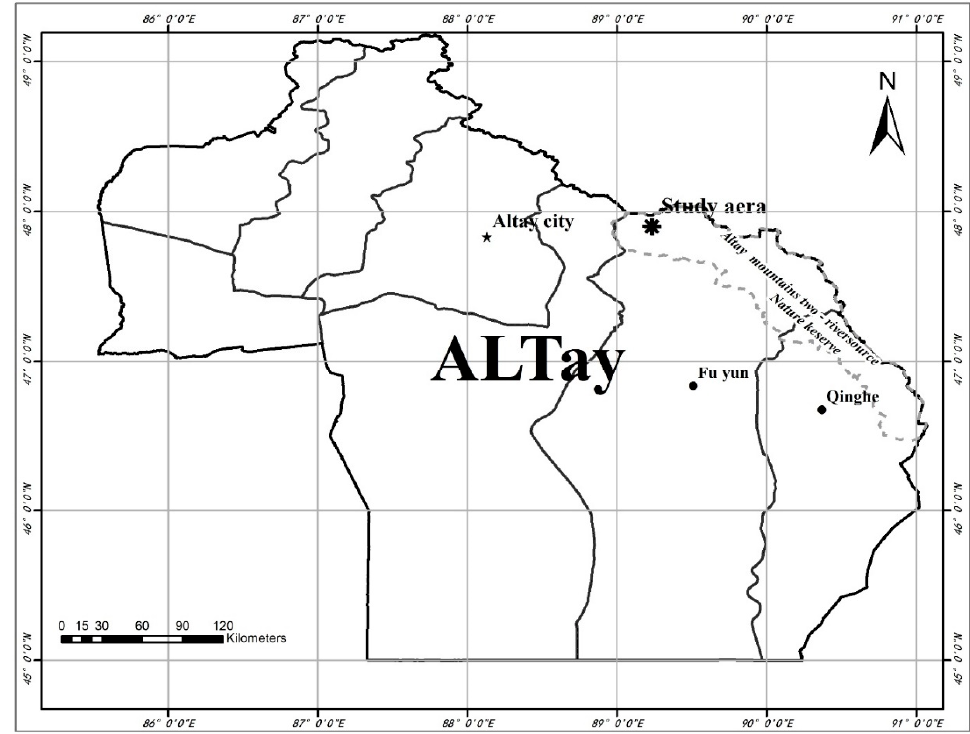
Figure 1. Location of study